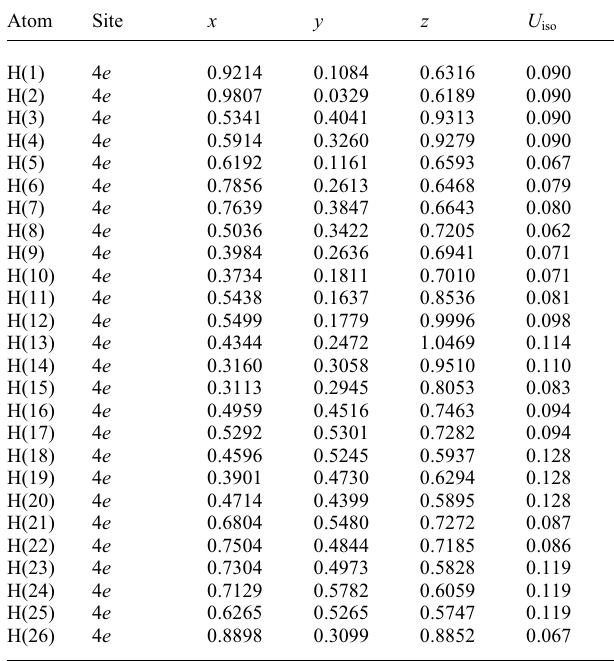
Table 2. Atomic coordinates and displacement parameters (in Å 2 )